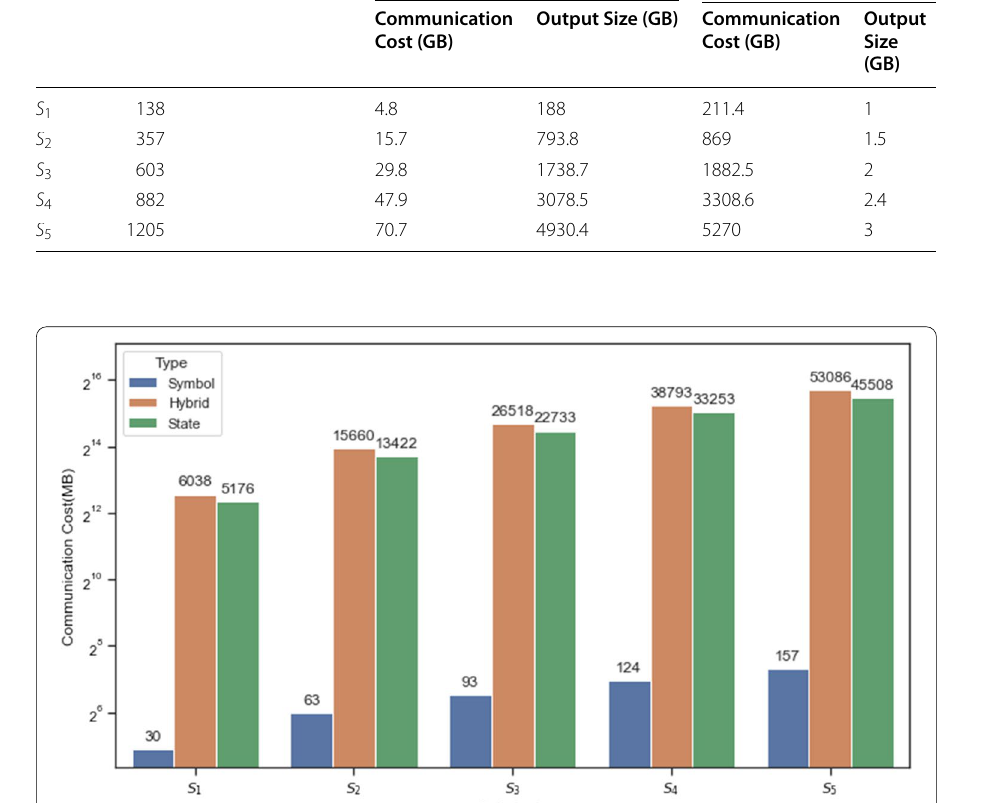
Fig. 5 Communication cost of the three proposed methods in the intersection